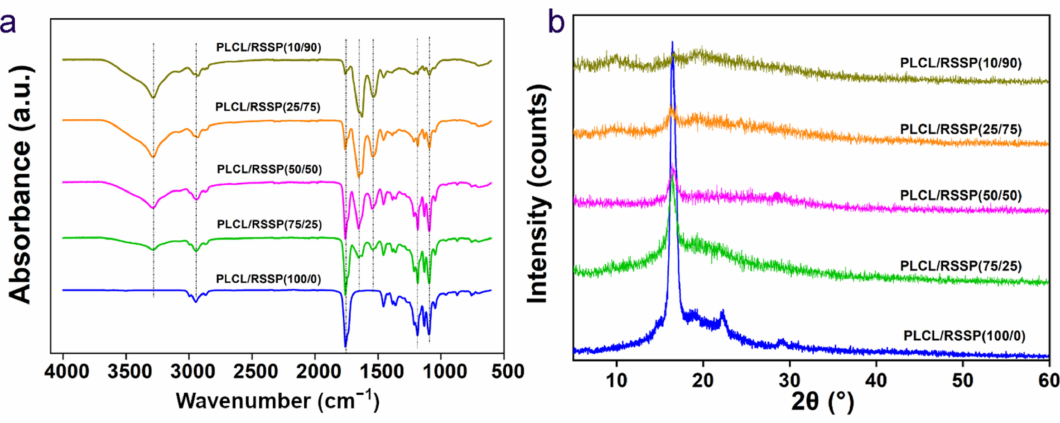
Figure 3. Chemical structure of nanofibrous membrane. ( a ) FTIR spectra. ( b ) WAXD